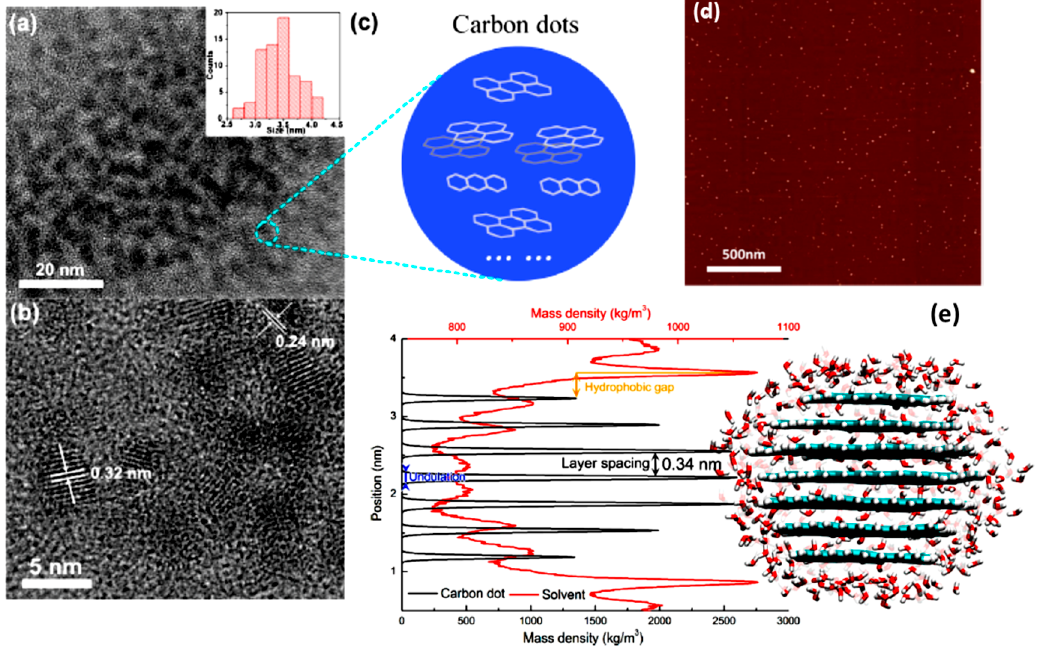
Figure 4. TEM and AFM images of CDs and structure of CDs by molecular dynamics calculations. Panels ( a ), ( b ), and ( c ) from [61] with permission of American Chemical Society, copyright 2015; panel ( d ) adapted from [47] with permission of American Chemical Society, copyright 2017; panel ( e ) from [63] with permission of American Chemical Society, copyright 2018.